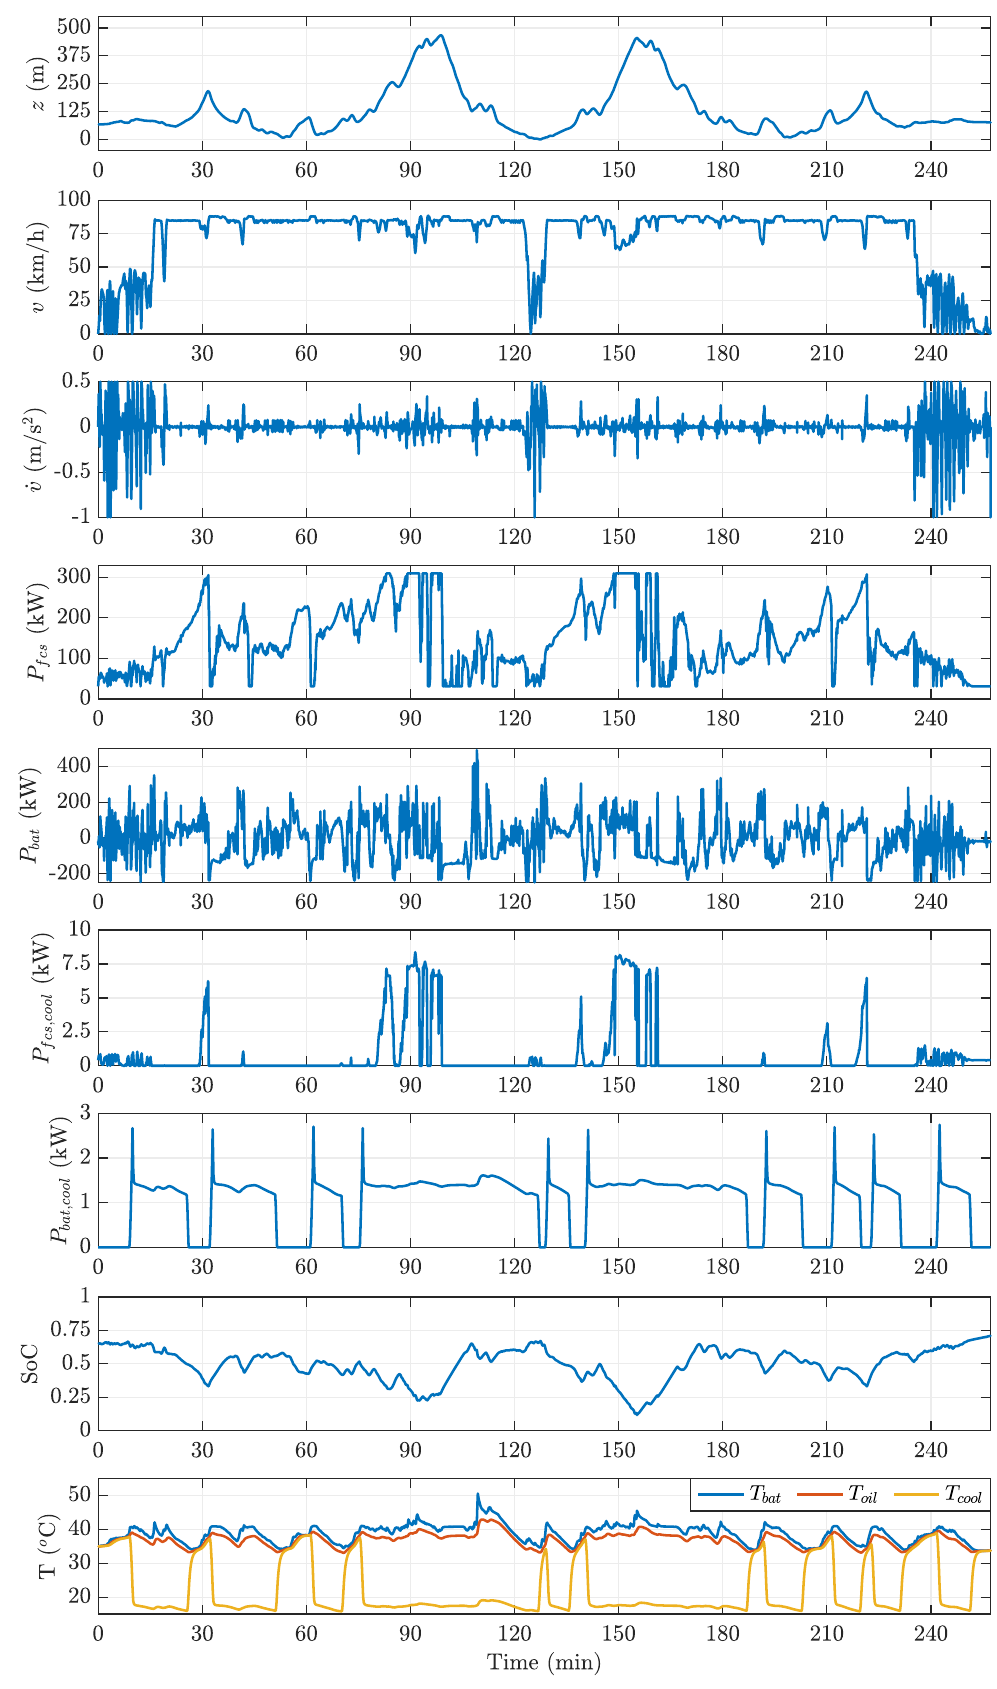
Figure 2. Driving simulation of a fuel cell electric truck (42 tons) in a real-world driving